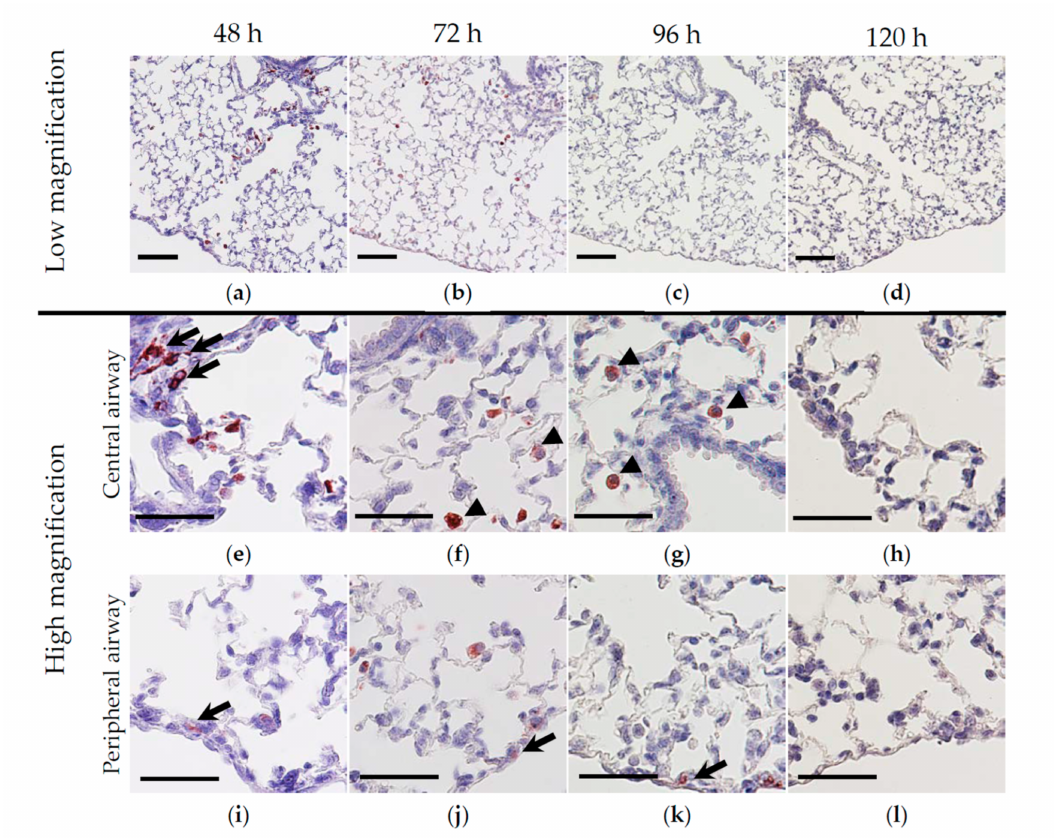
Figure 2. Immunohistochemical analysis of HO-1 in the lungs. Time course analyses of HO-1-positive cells performed at 48, 72, 96, and 120 h after nasal administration of 10 × 10 8 HO-1 lactis cells are shown in low ( a – d ; scale bar = 100 µ m) and high ( e – l ; scale bar = 50 µ m) magnification. ( a – d ) In the low-magnification images, HO-1-positive cells (red) are dominant in the central airways at 48 h ( a ) and then migrated / translocated to peripheral lesions at both 72 h ( b ) and 96 h ( c ). Finally, HO-1-positive cells disappeared in both the central and peripheral airways at 120 h ( d ). ( e – h ) In the high-magnification images of the central airways, HO-1-positive airway epithelial cells (arrows) were only seen at 48 h ( e ), whereas HO-1-positive macrophages (arrowheads) were maintained up to 72 h ( f ) and 96 h ( g ) and then disappeared at 120 h ( h ). ( i – l ) In the high-magnification images of the peripheral airways, HO-1-positive airway epithelial cells (arrows) were seen at 48 h ( i ), 72 h ( j ), and 96 h ( k ), and then disappeared at 120 h ( l ). Similar results were observed in 3–4 mice, and representative images are